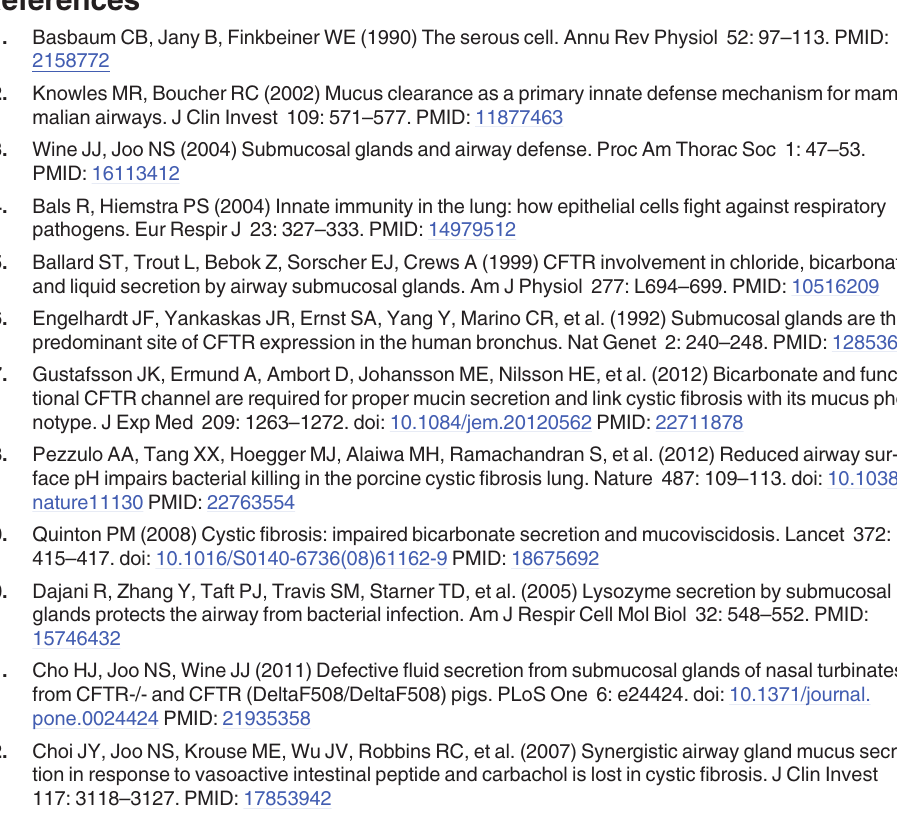
S5 Table. Biological activities of 269 proteins found in at least 2 of 3 HN mucus samples. The list of 269 proteins is arranged according to their relative abundance. S6 Table. HN peptides with additional MS/MS information. S7 Table. HN Proteins with additional MS/MS